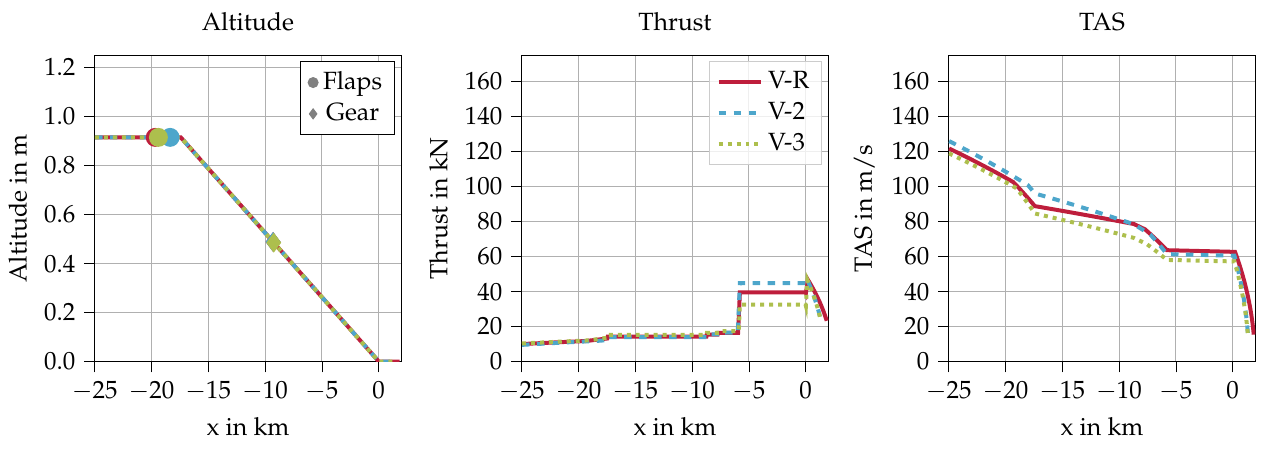
Figure 7. Approach trajectories: current engine option (BPR =